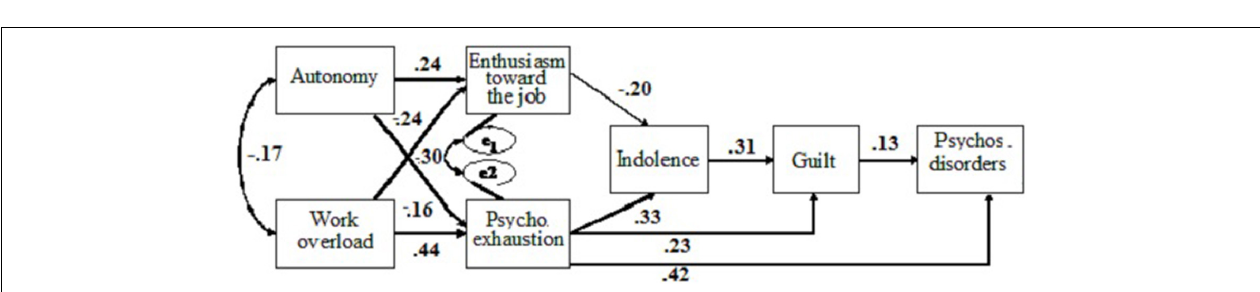
FIGURE 3 | Standardized coefficients for the modified model, taking into consideration feelings of guilt as predictor of psychosomatic disorders for the Portuguese sample.